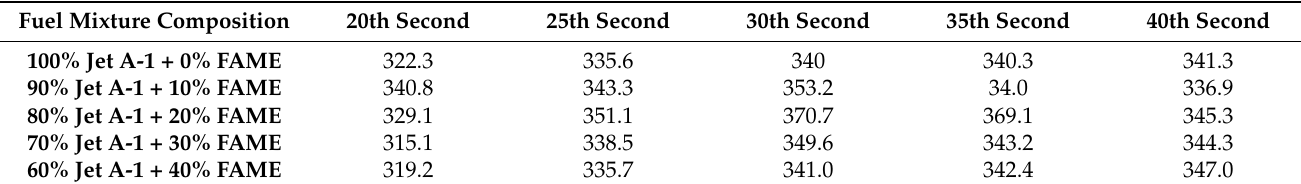
Table 18. Change in the maximum total gas temperature behind the gas turbine t 4t , max. [°C] SJE- 20 with different concentrations of Jet A-1 aviation kerosene and FAME biofuel.